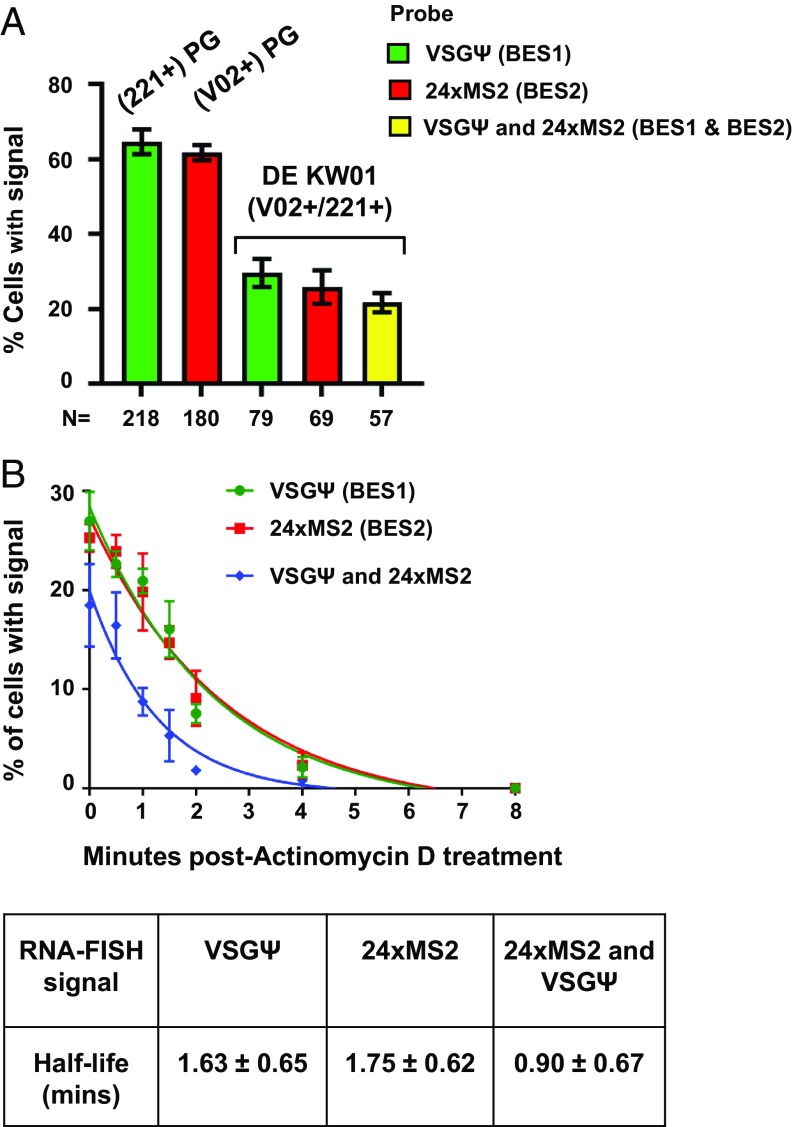
Transcription of unstably active ESs in double-expresser DE KW01 cells. (A) Quantitation of the percentage of cells with transcripts detectable from BES1 (VSGΨ), BES2 (24× MS2 repeats), or both BES1 and BES2 in the single-expresser (221+)PG-VHC and (V02+)PG-VHC strains or the double-expresser DE KW01 line. Data were obtained from RNA FISH experiments performed on G1 cells analyzed using superresolution microscopy. Values shown are the averages ± SD from 3 biological replicates with total number of cells (N) indicated below. (B) Half-life of the RNA FISH signal from BES1 (VSGΨ) or BES2 (24× MS2 repeats) transcription foci in the DE KW01-MS2-V02 cell line following treatment with sinefungin and actinomycin D. Half-lives of each RNA FISH signal in minutes (min) are shown in the table. The values shown are the averages ± SD of 3 biological replicates, with at least 300 cells counted per time point.